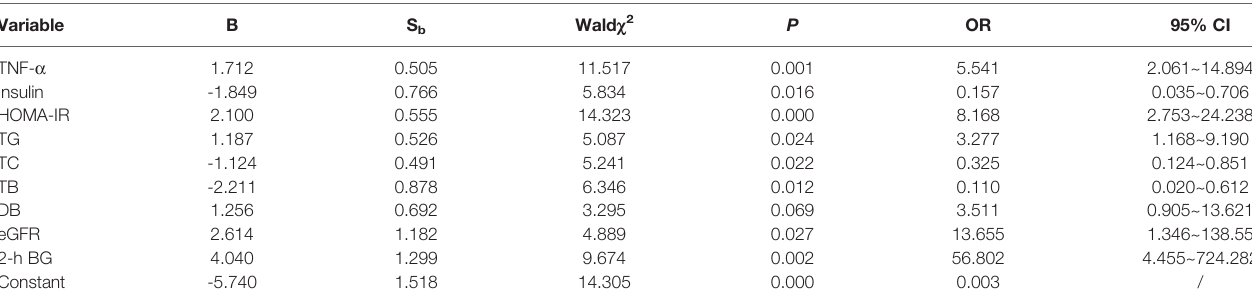
TABLE 4 | In fl uence factors involved in the process from prediabetes to T2DM. Variable